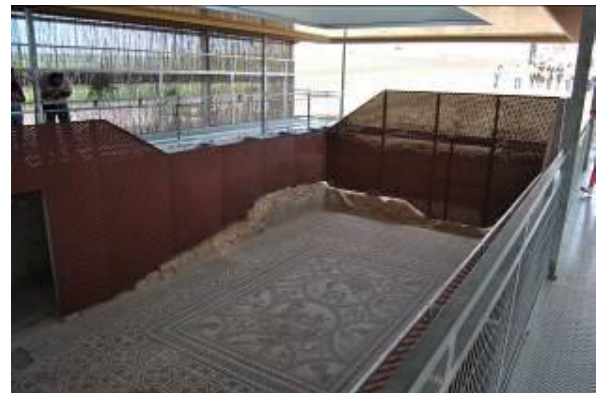
Figure 2. Current state of the Sala del Mosaico de los